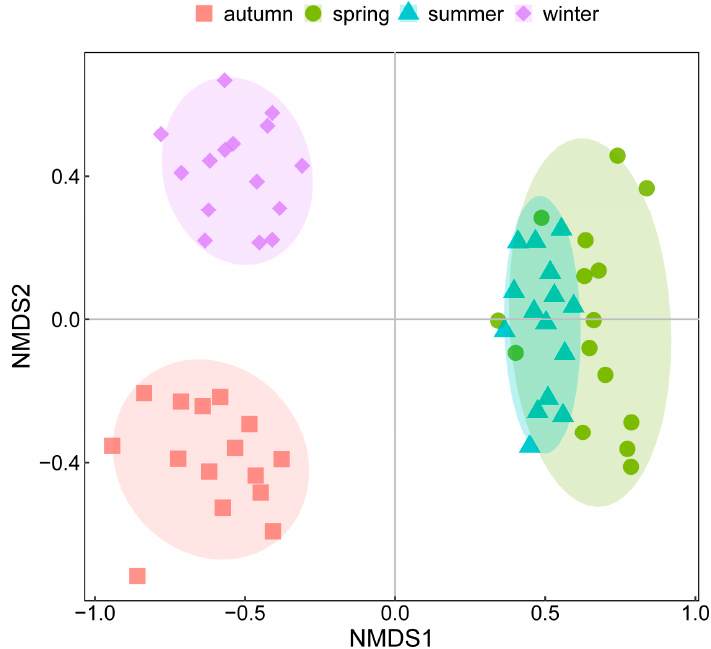
Figure 3. nMDS results of phytoplankton communities based on log-transformed abundance.